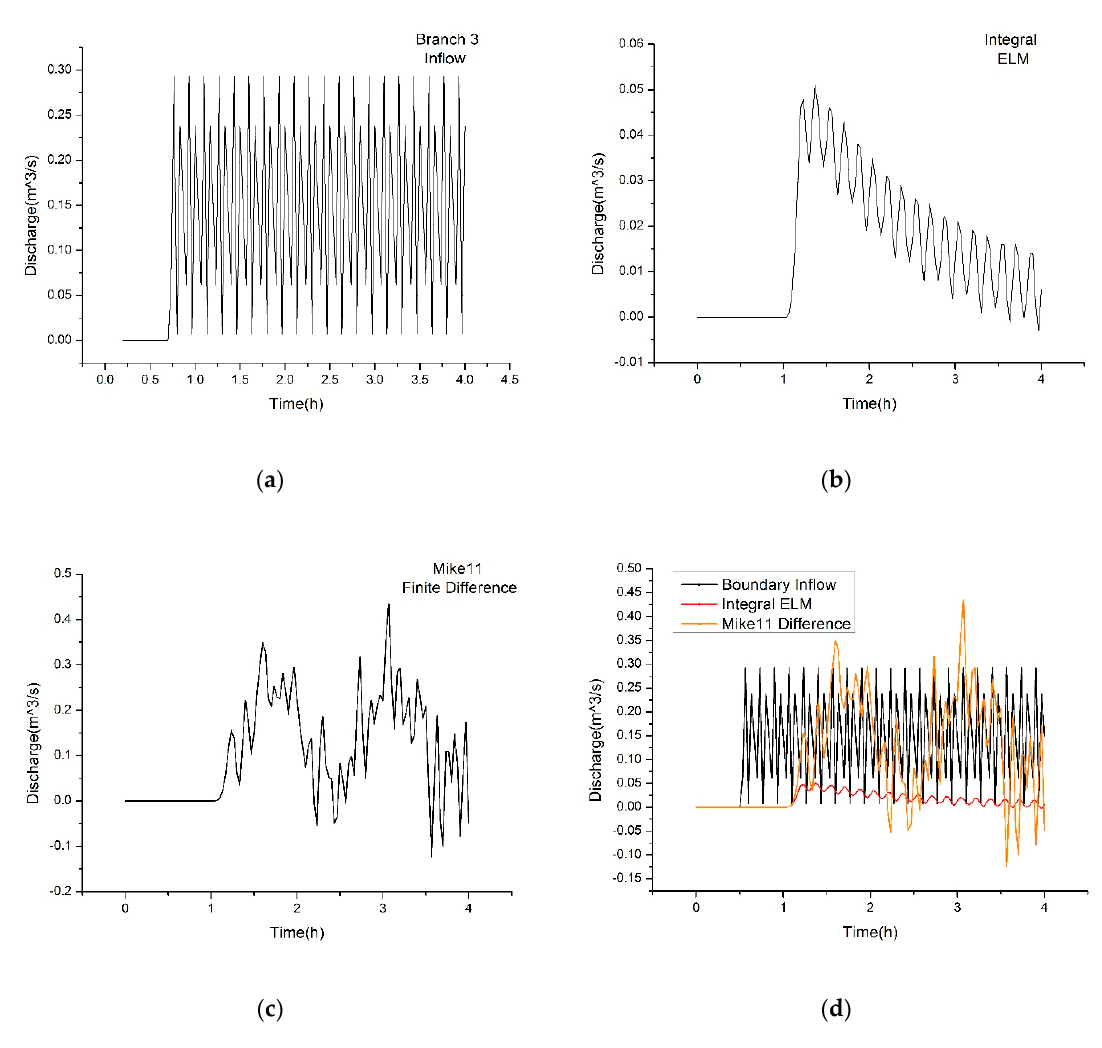
Figure 9. Boundary conditions and results of loop network 2: ( a ) inflow discharge of Branch 3, ( b ) results of integral ELM, ( c ) results of MIKE11, and ( d ) comparison between inflow and results.